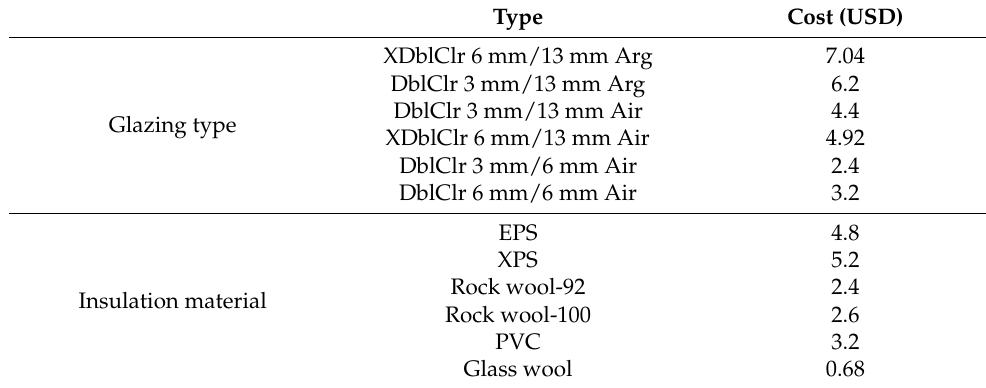
Table 2. The selected passive retrofitting